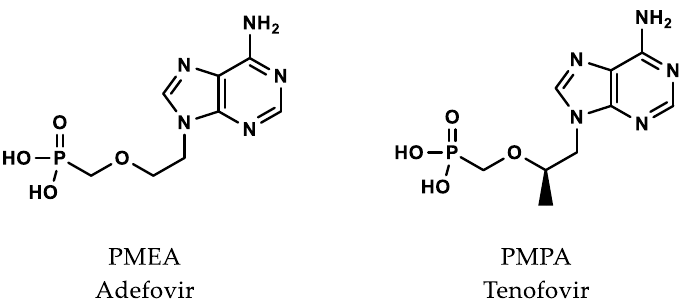
Figure 1. PMEA and PMPA differ in structure by one methyl group.